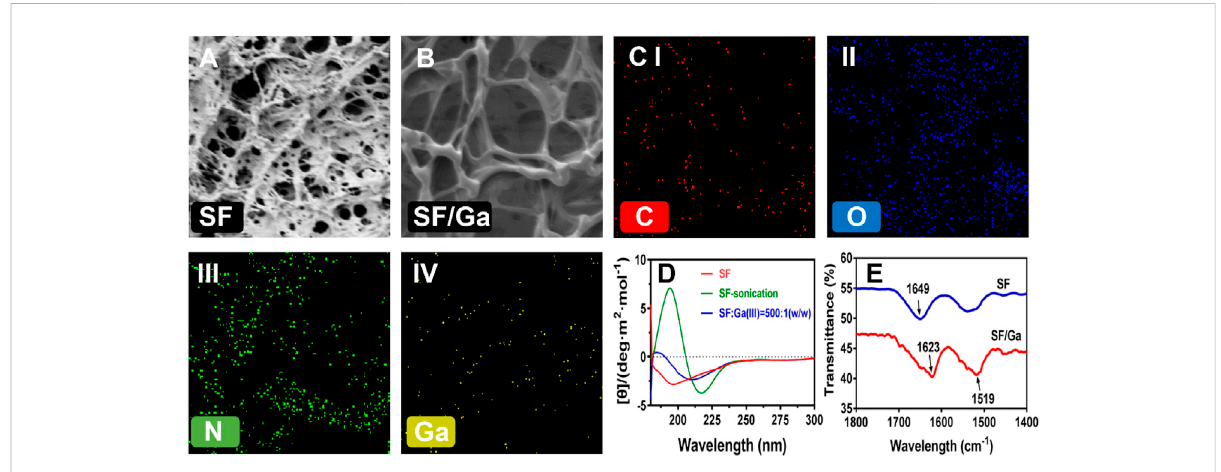
FIGURE 3 Morphological and secondary structural characterization. (A,B) SEM images of the surface pore of SF and SF/Ga hydrogel, (C) Elemental mappingofSF/Gahydrogel, (D) CDspectrumofunsonicated SF,ultrasonicatedSF,andsonicatedSF/Gasolutions, (E)